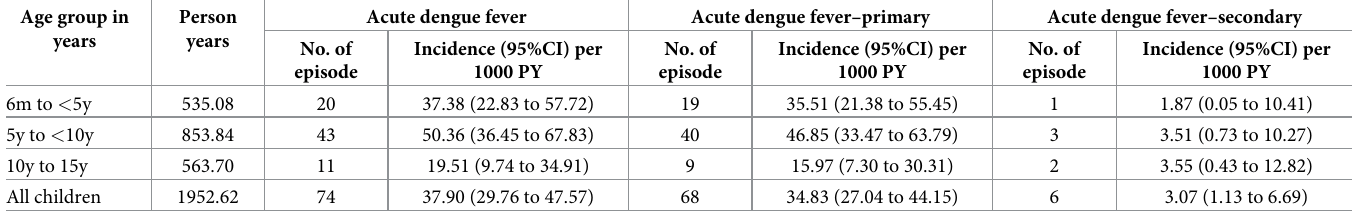
Table 3. Incidence of dengue fever by age-categories in the cohort (n = 984). Age group in